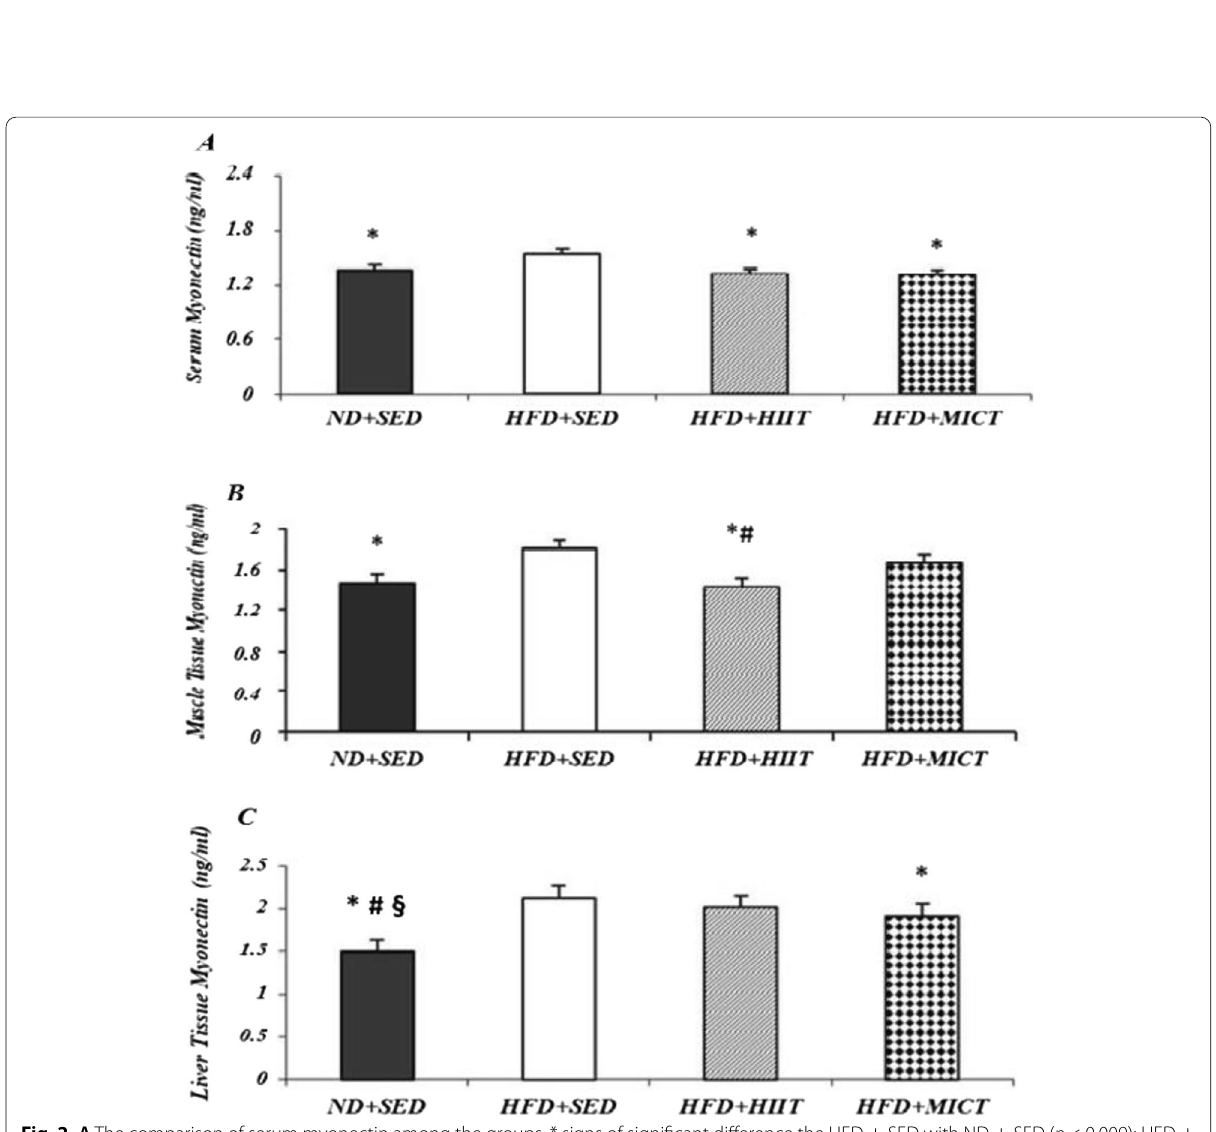
Fig. 2 A The comparison of serum myonectin among the groups. * signs of significant difference the HFD HIIT ( p < 0.003); and HFD MICT ( p < 0.006). B The comparison of muscle tissue myonectin among the groups. * signs of significant difference the + HFD SED with ND SED ( p < 0.04) and HFD HIIT ( p < 0.04); # signs of significant difference with the HFD + + + of liver tissue myonectin among the groups. * signs of significant difference the HFD # signs of significant difference with the HFD MICT ( p < 0.001); § signs of significant difference with the HFD +